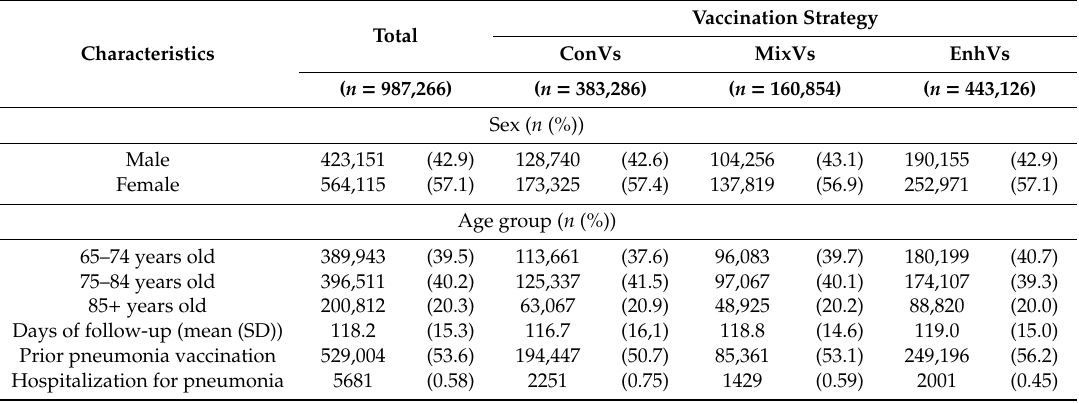
Figure 1. Hospitalization rate (%) and number of subjects with pneumonia by flu season. When the hospitalization rate was considered by vaccination group, the enhanced vaccines (EnhVs) group (2001 cases; 0.45%) and the conventional/enhanced vaccines (MixVs) group (1429 cases; 0.59%) had significantly lower rates than the conventional vaccines (ConVs) group (2251 cases; 0.75%), with p < 0.001. The difference in the number of admissions between the EnhVs Group and the MixVs Group was also significant (0.45% vs. 0.59%; p < 0.001). * AAPC = 10.8; 95% CI: − 3.5–27.1. Table 1. Individuals vaccinated against the flu in the Friuli Venezia Giulia region by vaccination strategy and characteristics, in six consecutive flu seasons (2011/2012 to 2016/2017).